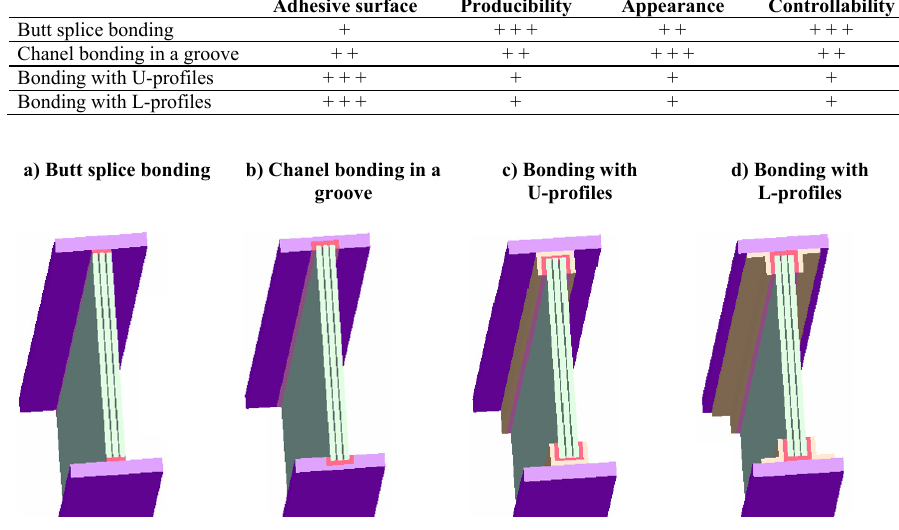
Figure 2: Four joining details of the bonded